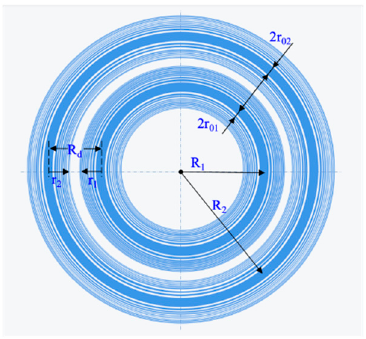
Figure 10. Schematic diagram of double-ring AFZP.